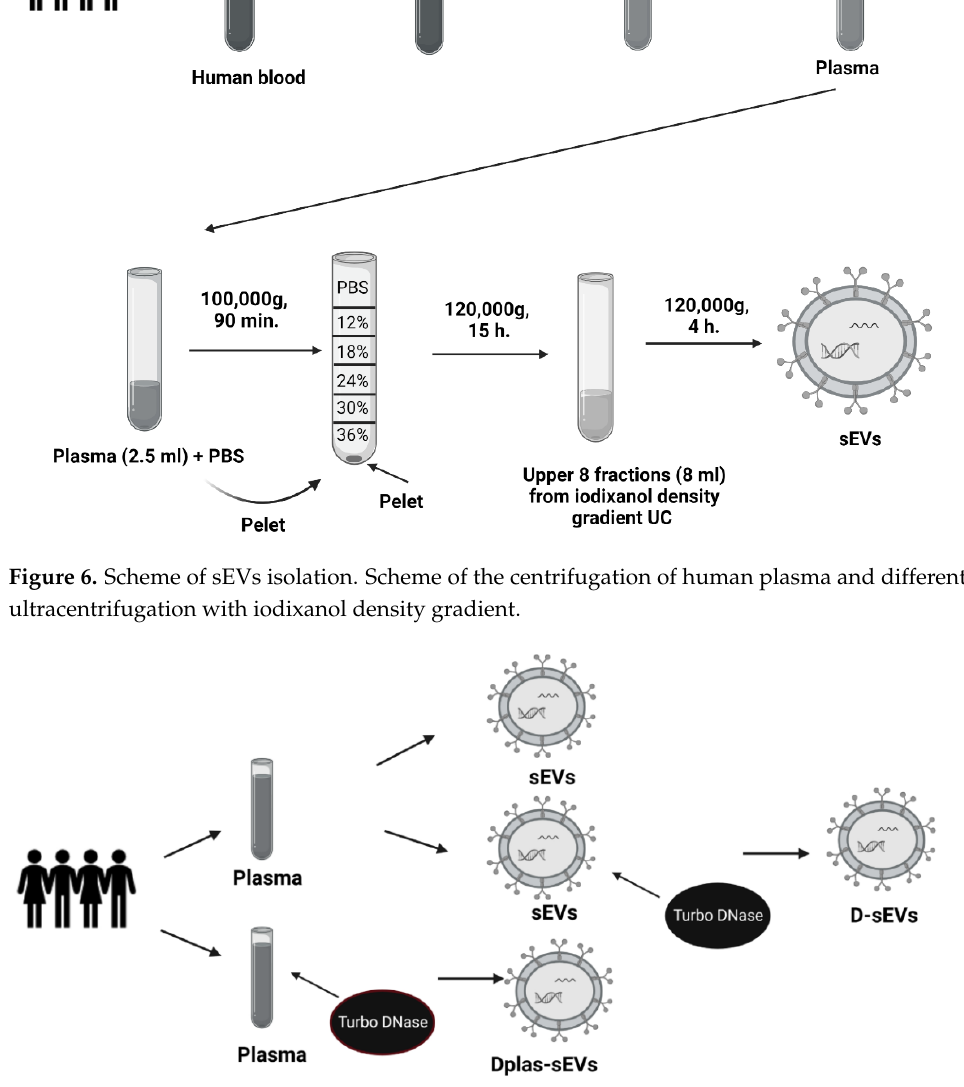
Figure 7. Scheme of sEVs samples. sEVs — small extracellular vesicles from DNase-free plasma;